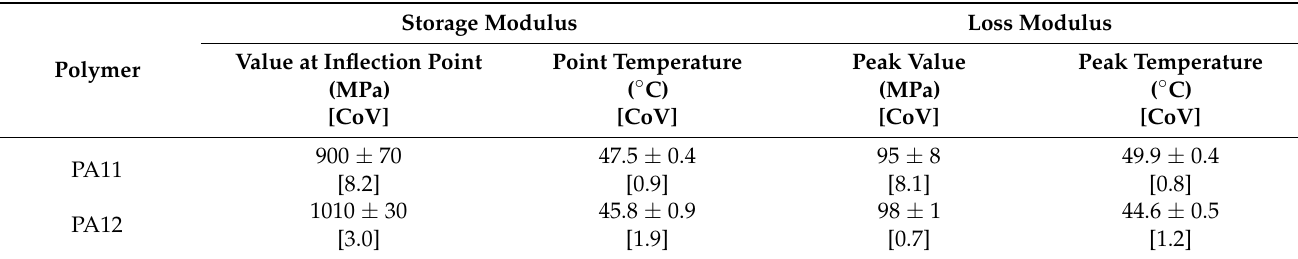
Table 6. Inflection points for storage modulus and peak value for loss modulus for the polymers and their associated temperatures.